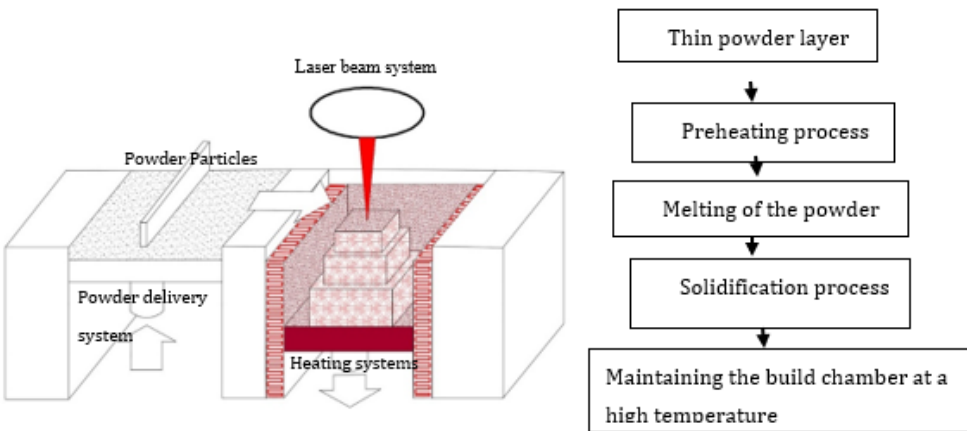
Figure 5. Schematic representation of the conceptualized LPBF manufacturing system.